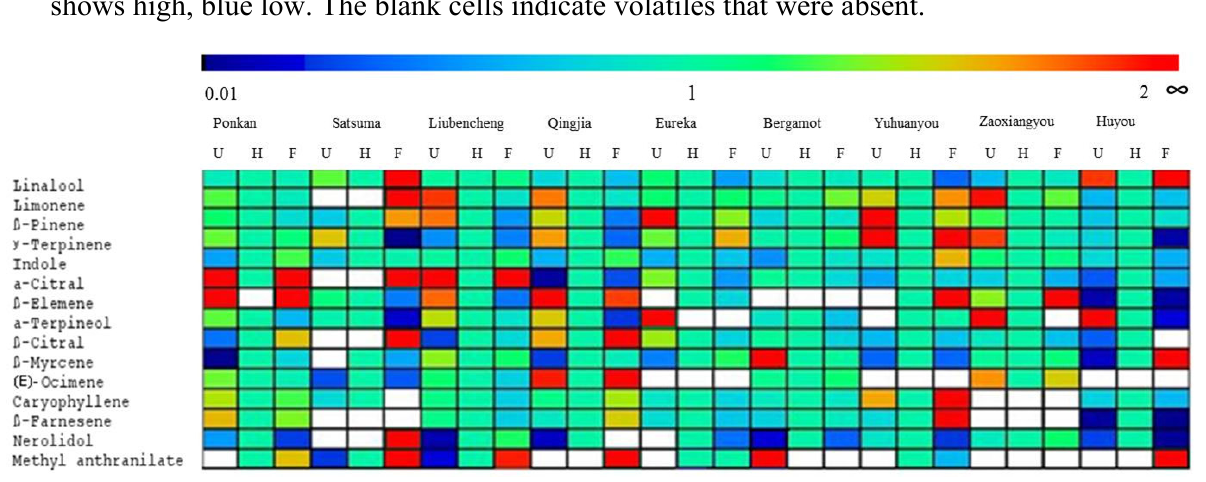
Figure 3. Ratio of major flower volatiles in either unopened (U) or fully opened (F) to half opened (H) flowers from nine citrus cultivars. Color code shown above the figure: red shows high, blue low. The blank cells indicate volatiles that were absent.